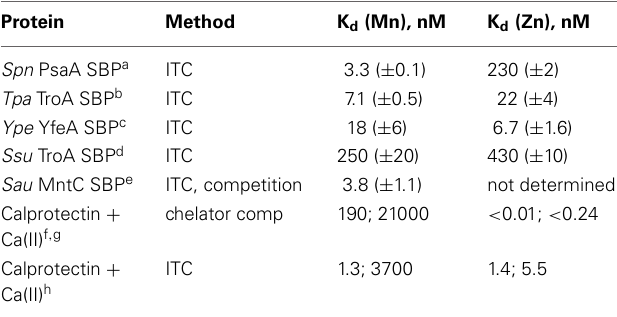
Table 1 | Equilibrium dissociation constants ( K d ) reported for solute binding proteins of Mn-specific ATP-binding cassette transporters and for human